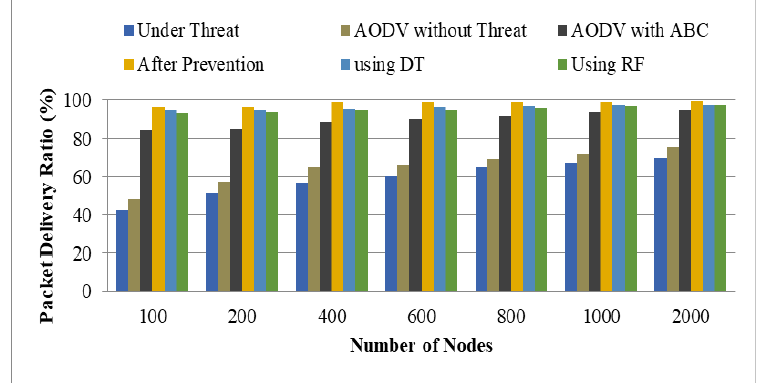
Figure 13. Packet delivery ratio. As per the given graph shown in Figure 13, it is clear that the proposed approach (modified AODV) using ABC and ANN with the SVM method performed well. The values were analyzed concerning the number of nodes as indicated on the x-axis. To show the enhancement comparison, other considered scenarios were presented. The average value analyzed with AODV under threat, AODV without threat, AODV with ABC, after prevention, using Decision Tree (DT), and using Random Forest (RF) was observed as 59.07, 64.94, 89.67, 97.96, 96.08, and 95.12, respectively. Therefore, the highest PDR was examined for the proposed work. This is because of the dual ML algorithm that improves throughput.